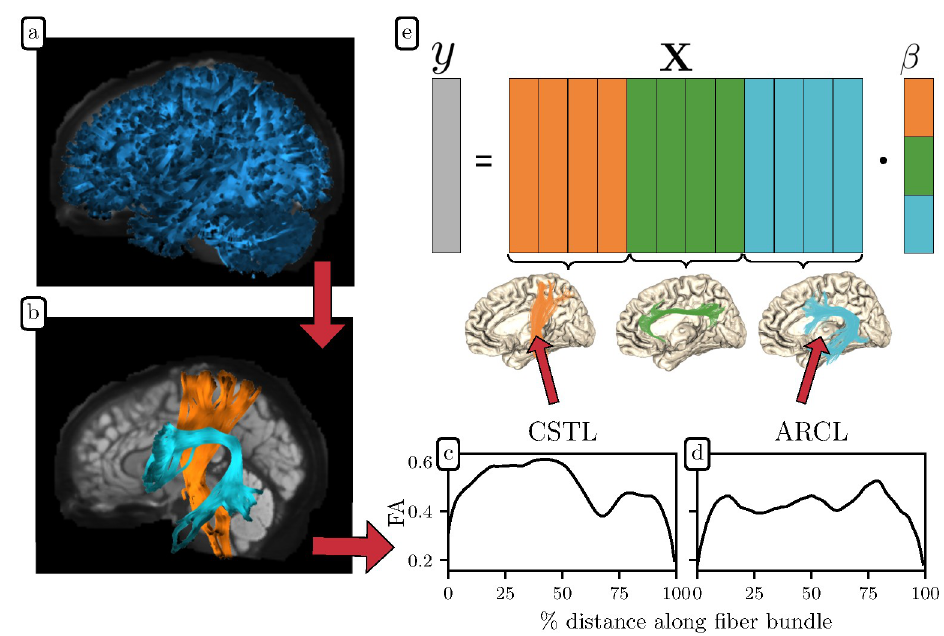
Fig 1. Tractometry data flow. (a) Whole brain tractography generates streamlines approximating the trajectories of white matter connections. (b) Tractometry classifies these streamlines into anatomical bundles. In this case, we show the left corticospinal tract (CSTL) and the left arcuate fasciculus (ARCL) over a mid-saggital anatomical slice. Tract profiling further extracts bundle profiles, quantifications of various diffusion metrics along the length of the fiber bundle. Here, we show one subject’s fractional anisotropy (FA) profile for (c) the CSTL and (d) the ARCL. (e) the phenotypical target data and tract profile features can be organized into a linear model, ^ y ¼ X ^ b . The feature matrix X is color-coded to reveal a natural group structure: the left (orange) group contains k features from the CSTL, the middle (green) group contains k features from the left cingulum cingulate (CGCL), and the right (blue) group contains k features from the ARCL. The coefficients in ^ b follow the same natural grouping. Panels (a) and (b) are adapted from https://figshare.com/articles/figure/example_tractography-segmentation/14485350, and reproduced under the CC-BY license